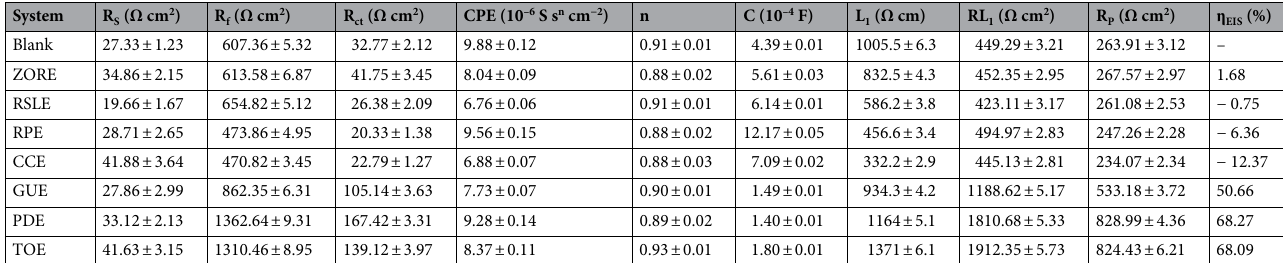
Table 2. Corresponding fitted parameters of EIS spectra of AZ91 Mg alloy in 3.5 wt% NaCl solution without and with addition of 1 g/L seven TCM extracts at normal